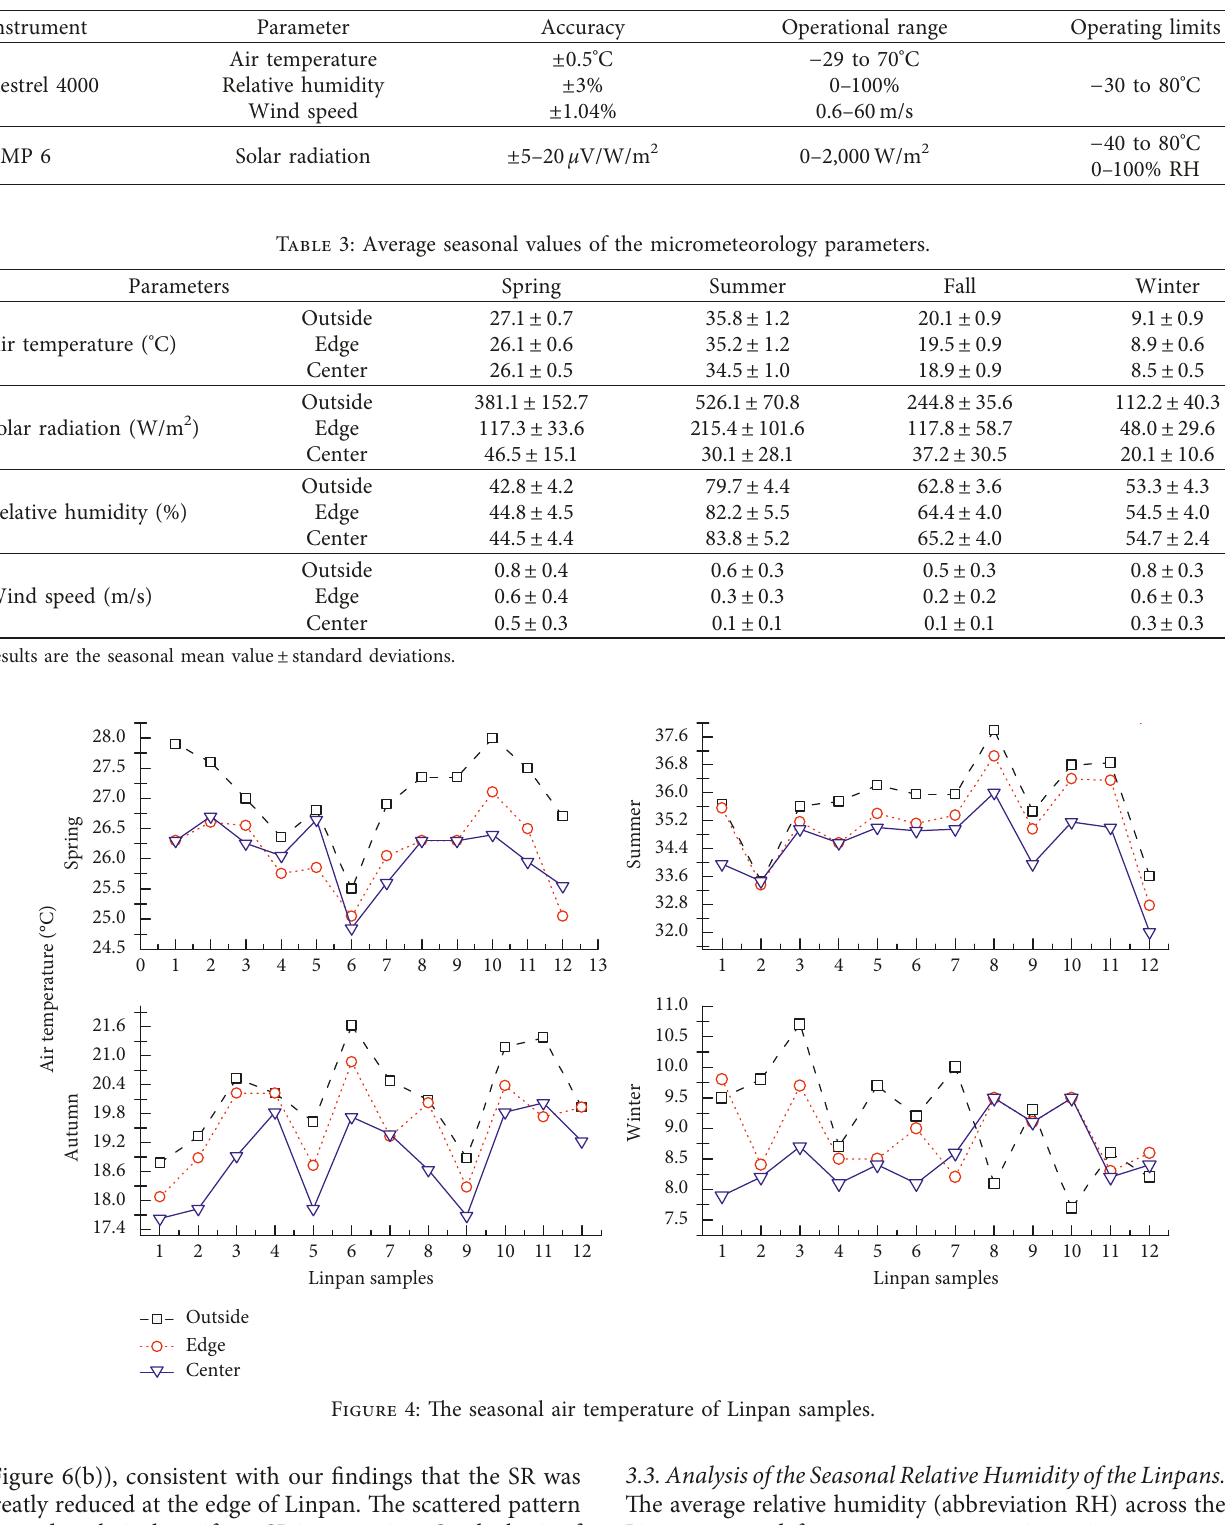
Table 2: Sensor characteristics.